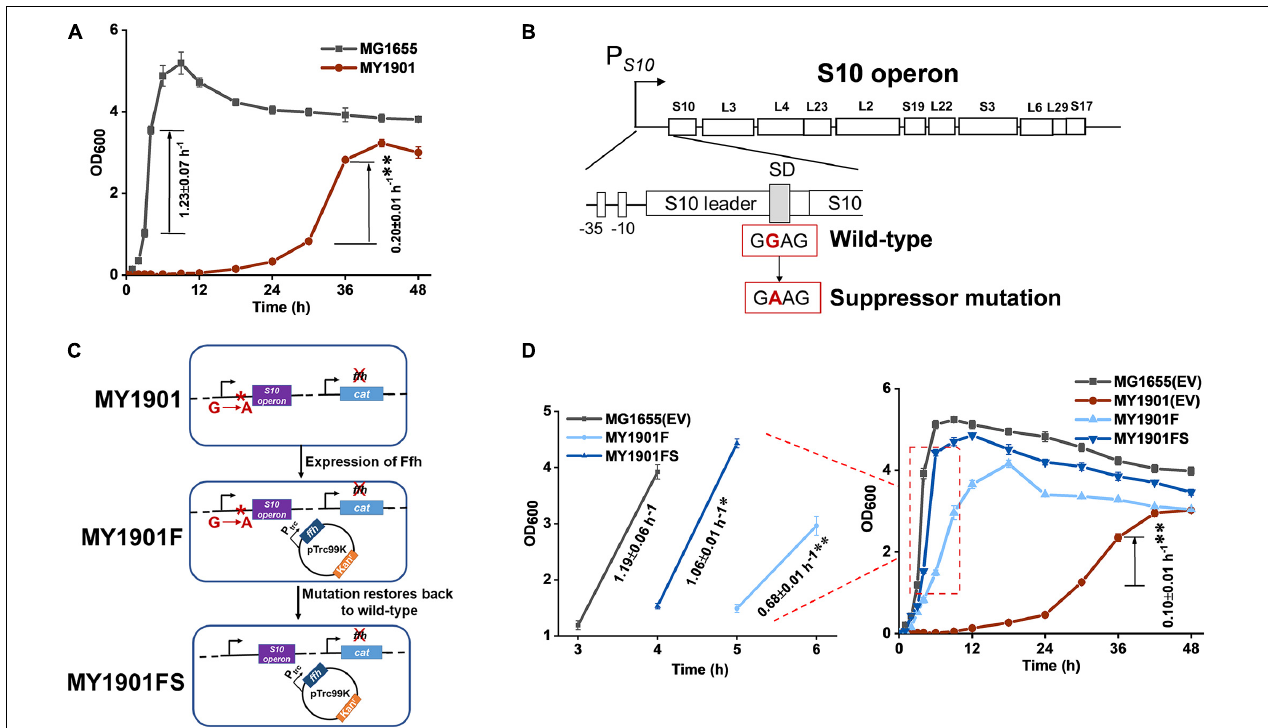
FIGURE 1 | Identification of SRP suppressor strain and its growth. (A) Growth curves and growth rates of the wild-type strain MG1655 and the suppressor strain MY1901. (B) The suppressor mutation sites in the SD sequence of S10 operon. The region and encoded ribosomal proteins of the S10 operon are shown. The wild-type SD sequence (GGAG) mutated into suppressor mutation (GAAG). (C) Restoration of the wild-type allele. Plasmid pTrc99K-Ffh was first transformed into strain MY1901, generating the strain MY1901F. Ffh protein was produced at low level in MY1901 to reduce the toxicity of overexpression of Ffh. Then, the suppressor mutation (GAAG) was restored to wild-type SD sequence (GGAG) by site-directed mutagenesis, generating the strain MY1901FS. (D) Growth curves and growth rates of four strains: MG1655 and MY1901carrying the empty vector (EV) pTrc99K, MY1901F, and MY1901FS. Strains MG1655 and MY1901 carrying the empty vector pTrc99K were used as control. Solid curves are the mean of three independent measurements, and error bars represent the standard deviation of the mean value. Growth rates were figured out from the logarithmic phase. All growth rates shown represent the mean ± standard deviation of three independent experiments. Statistical significance compared to wild-type strain using Student’s t -test is indicated as follows: * P < 0.05; ** P <